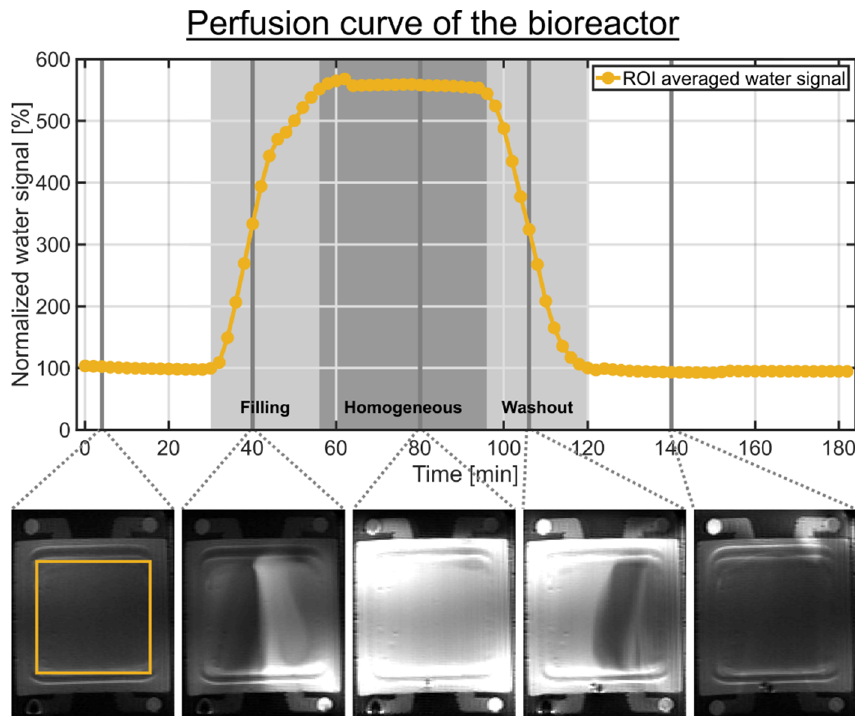
Figure 2. Perfusion curve of the bioreactor without MCA determined by a 60 min bolus containing 2 mM Dotarem medium. Selected 1 H RARE images are shown below the time course. The bolus start was around 2 min. The two light gray shaded backgrounds indicate the filling and washout of the bolus in the bioreactor, while the dark gray shaded background indicates the homogeneous distribution of the bolus in the bioreactor. The signal time course of each compartment represents the mean signal intensity of a ROI containing both compartments. An imaging slice, in the place which would contain the 3D cell culture in the presence of MCAs, was selected. The following time points are relative to the bolus start. After 28 min, the Dotarem bolus reached the bioreactor. From approximately 54 min until 90 min, the bolus was homogeneously distributed in the bioreactor. After 118 min, the bolus was completely removed from the bioreactor.